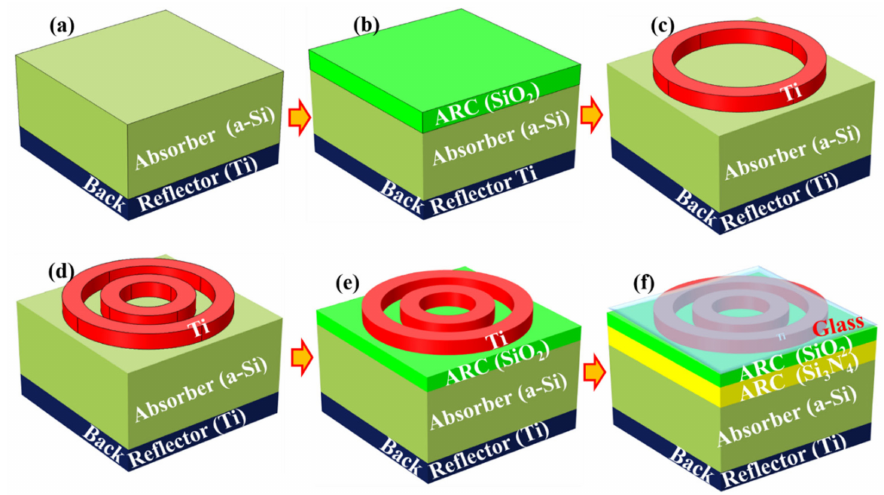
Figure 2. Schematic structure of ( a ) reference solar cell (S1), ( b ) solar cell with single antireflection coating (ARC) layer (S2), ( c ) solar cell with single nanoring (S3), ( d ) solar cell with double nanorings (S4), ( e ) solar cell with double nanorings and ARC layer (S5), and ( f ) a complete solar cell (S6).